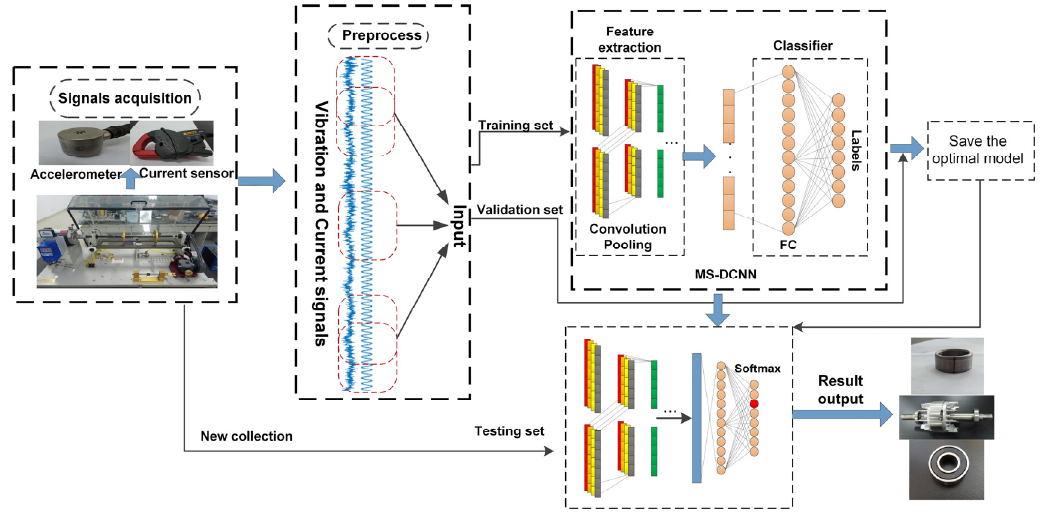
Figure 7. Motor compound fault diagnosis process.